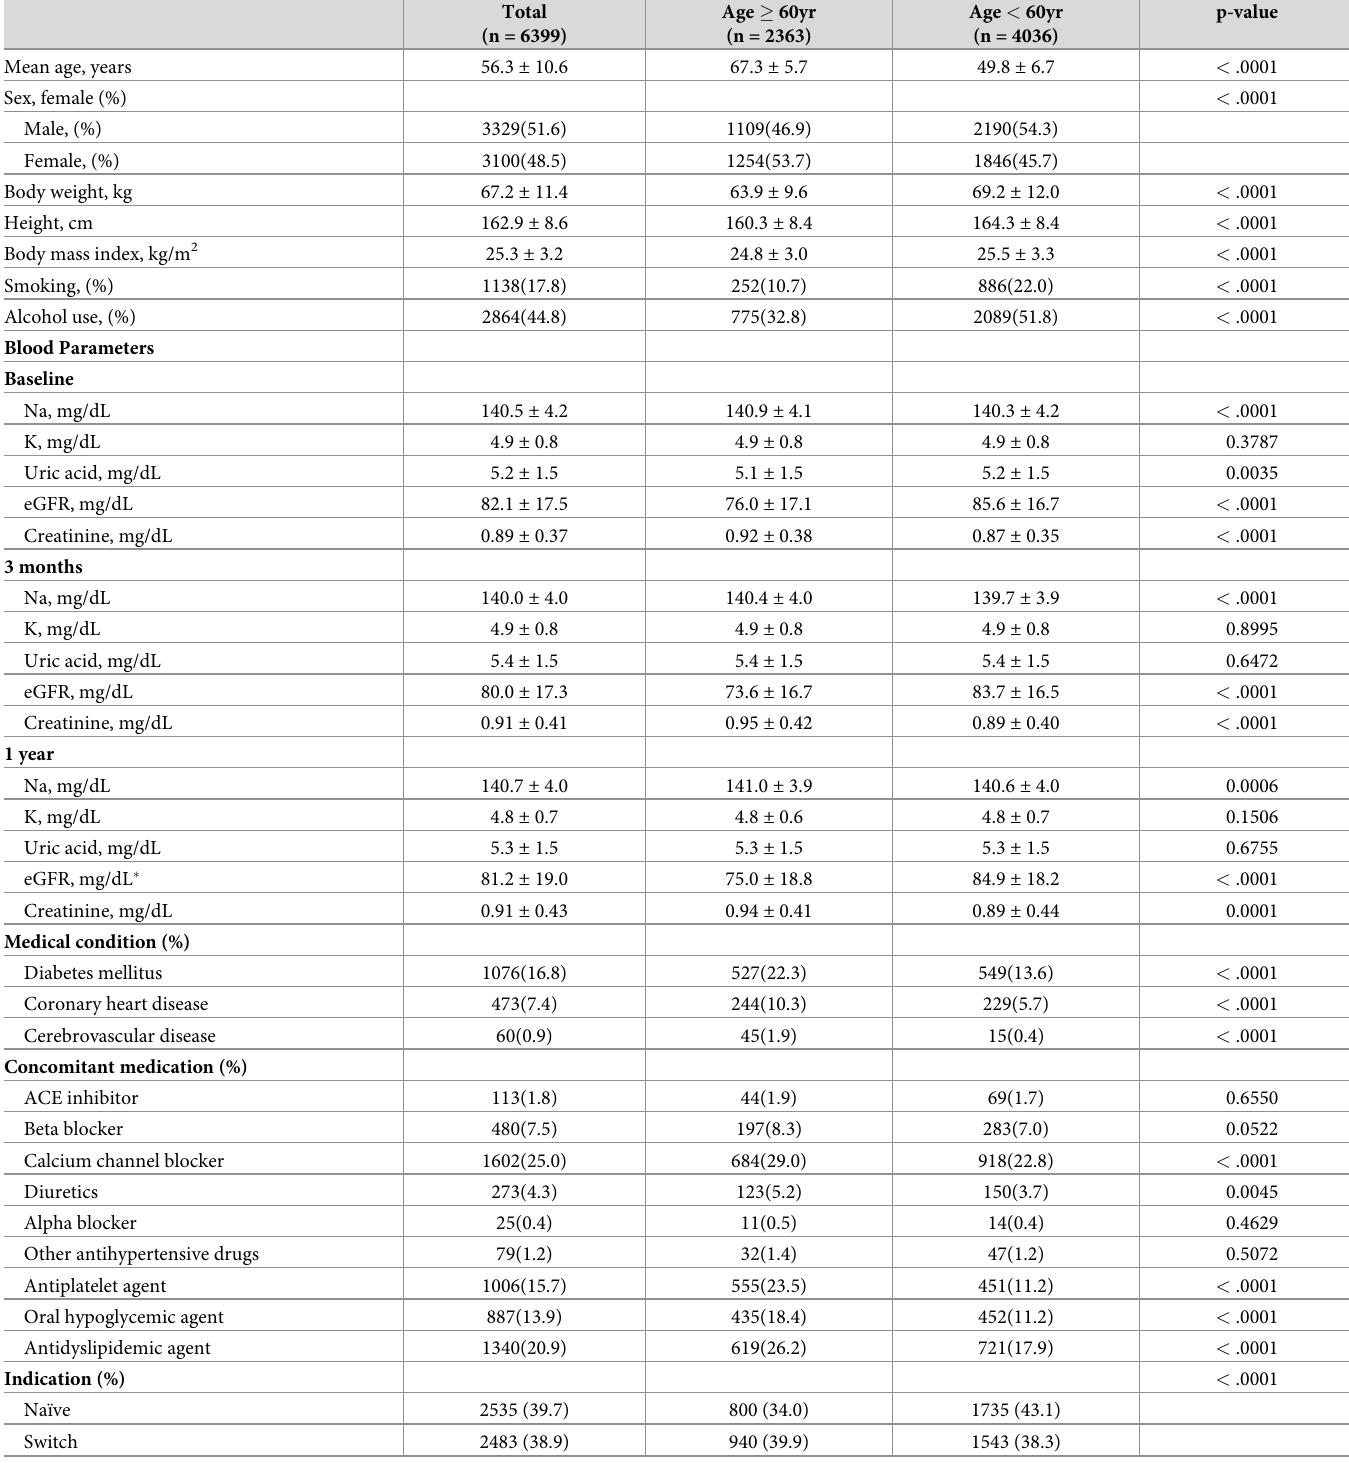
Table 1. Baseline characteristic (Age � 60yr vs. Age <